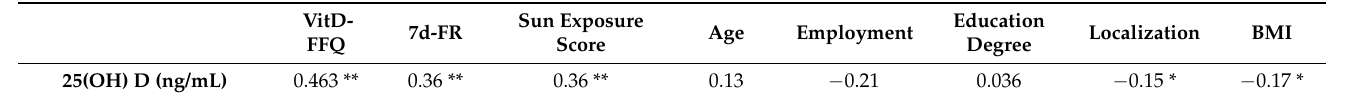
Table 5. Association between Vitamin D Status, dietary intake, UV Exposure score, BMI and socio- demographic characteristics of the participants.